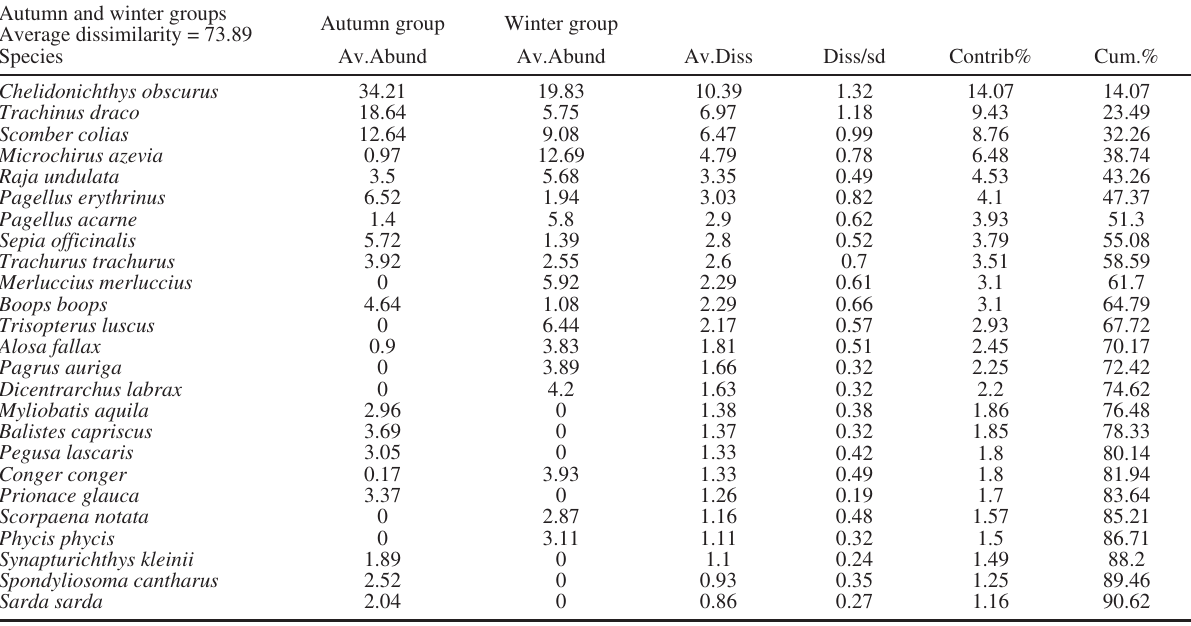
Table S4. – Simper analysis for the discards (commercial discards and by-catch) data for abundance with the factor target catch (sole season Soles and cuttlefish group Average dissimilarity =